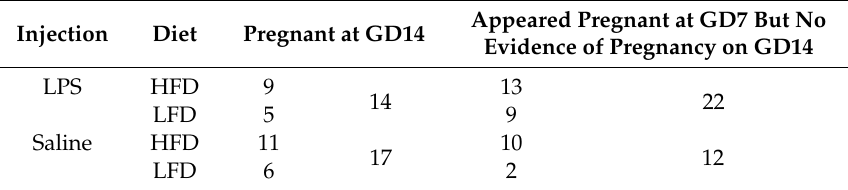
Table 2. Numbers of females fed a high-fat diet (HFD) or low-fat diet (LFD) for 13 weeks prior to mating, injected with lipopolysaccharide (LPS) or saline on gestational day 7 and found to be pregnant or not pregnant on gestational day